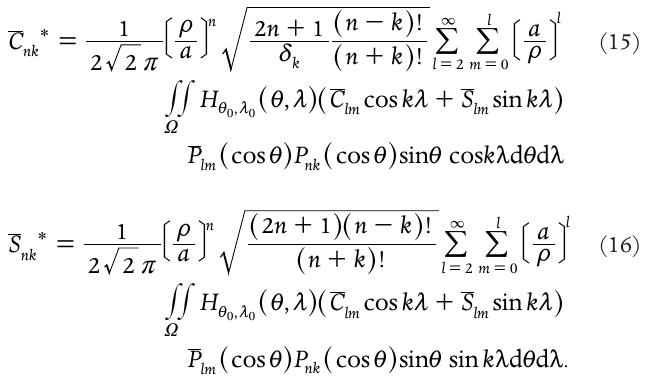
on the spherical i